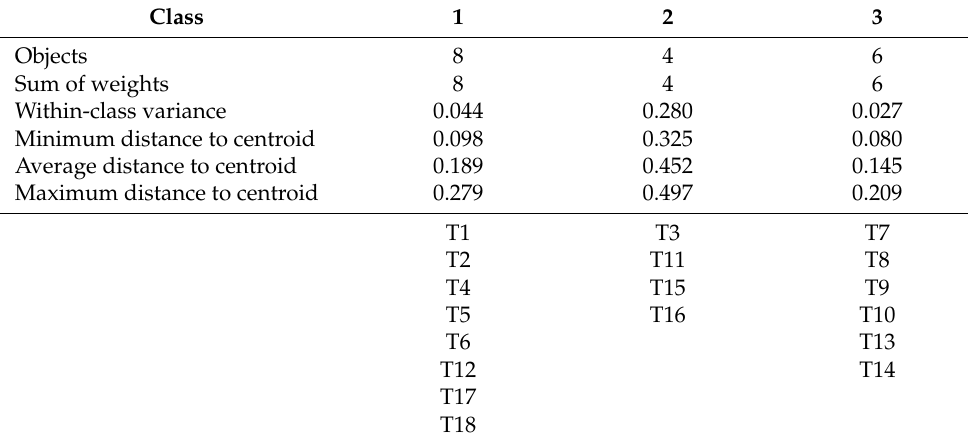
Figure 4. AHC Dendrogram of treatments. Table 12. AHC analysis results through class.